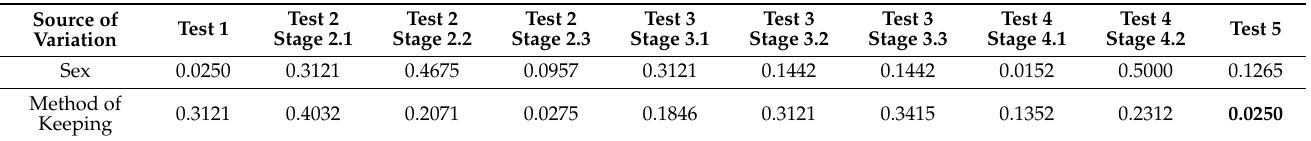
Table 4. Probability values ( p -Value) adjusted for a one-way alternative hypothesis and a small group size (<20) the values statistically significant at 0.05 are in bold.